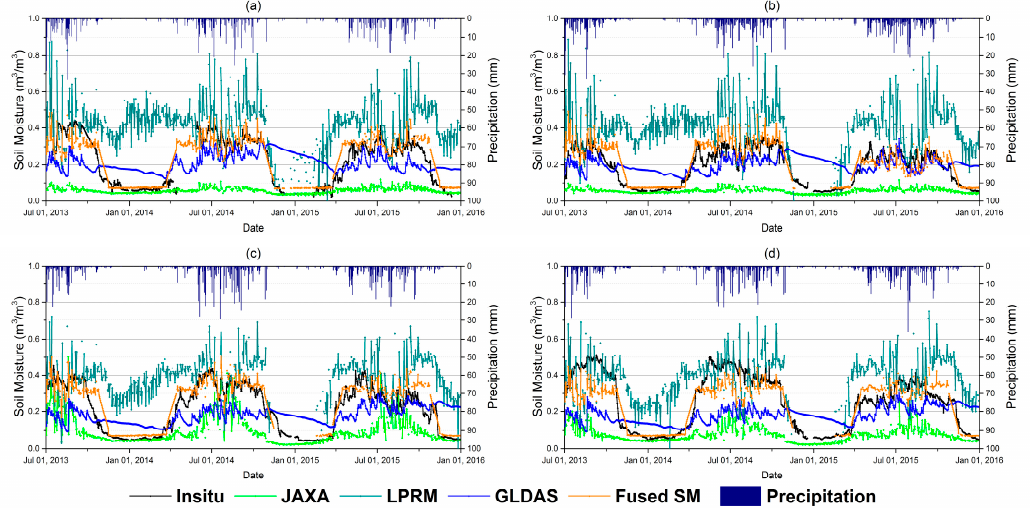
Figure 4. Comparison of the JAXA, LPRM, and GLDAS SM products and the fused SM data, together with the in situ data and precipitation measurements collected at: ( a ) WATER-NET 1; ( b ) WATER-NET 2; ( c ) WATER-NET 3; and ( d ) WATER-NET 4.